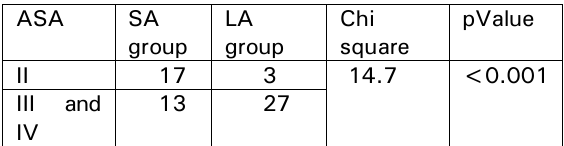
Table 3: Comorbid disease according to ASA classification